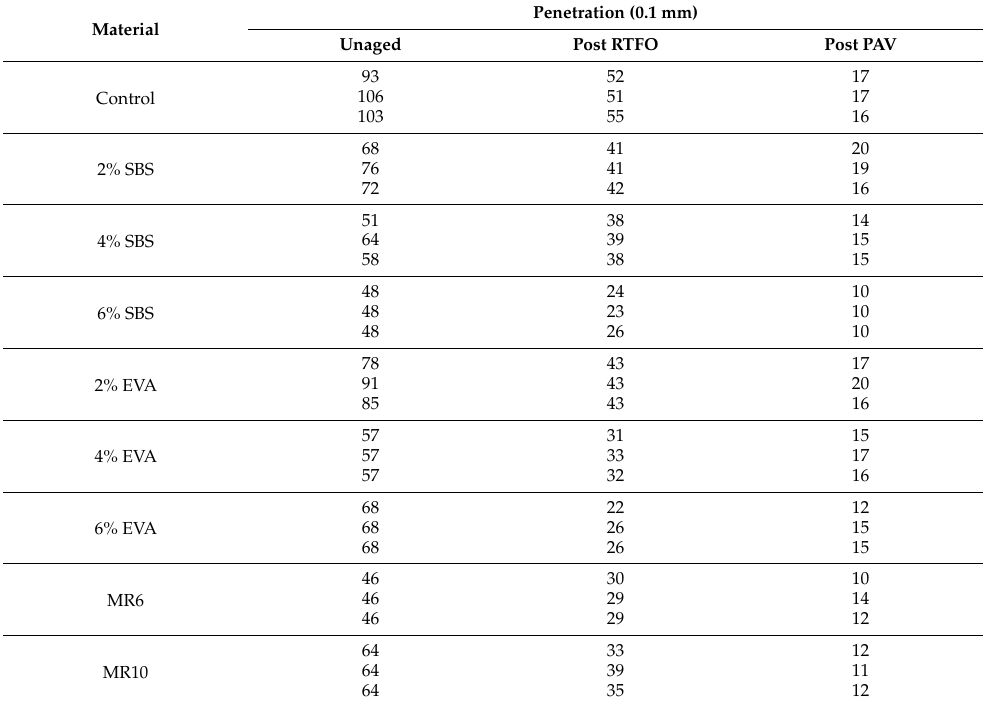
Table 3. Binder penetration results.